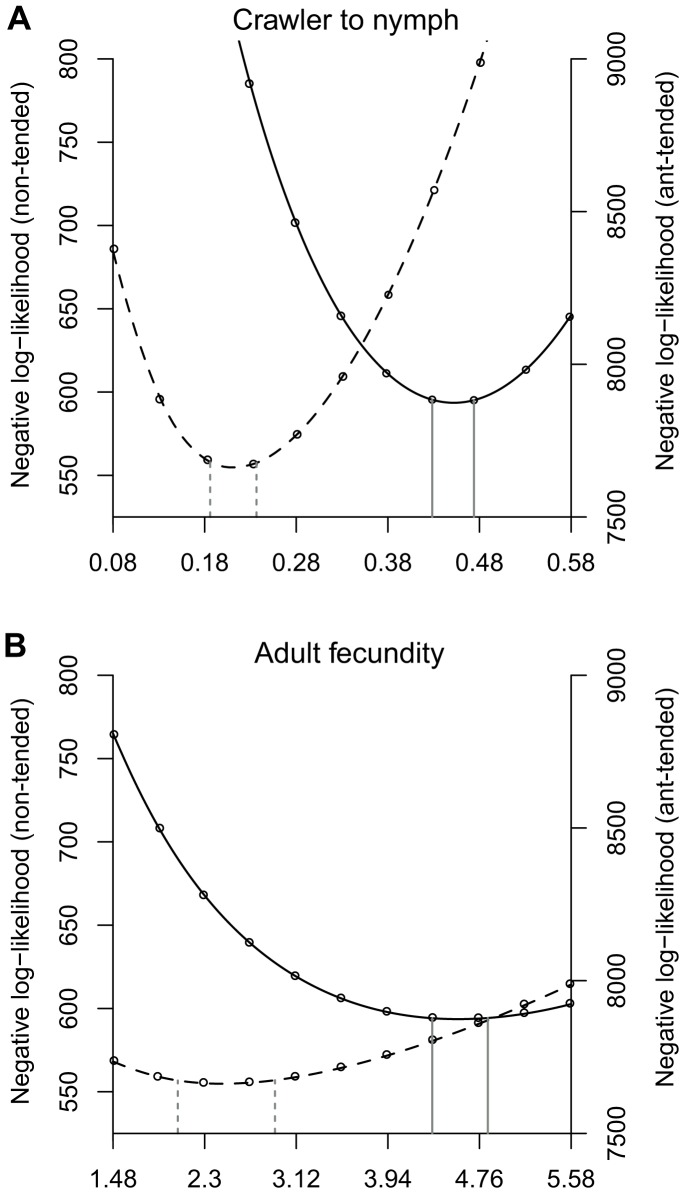
Negative log-likelihood profiles.Profiles for (A) the transition probabilities of crawler to nymph and (B) the mean adult fecundity for C. viridus. In both graphs, ‘ant-tended’ (solid curves) and ‘non-tended’ (dashed curves) populations are indicated. The vertical lines show the 95% confidence limits for the prediction of these probabilities calculated by the likelihood ratio test.